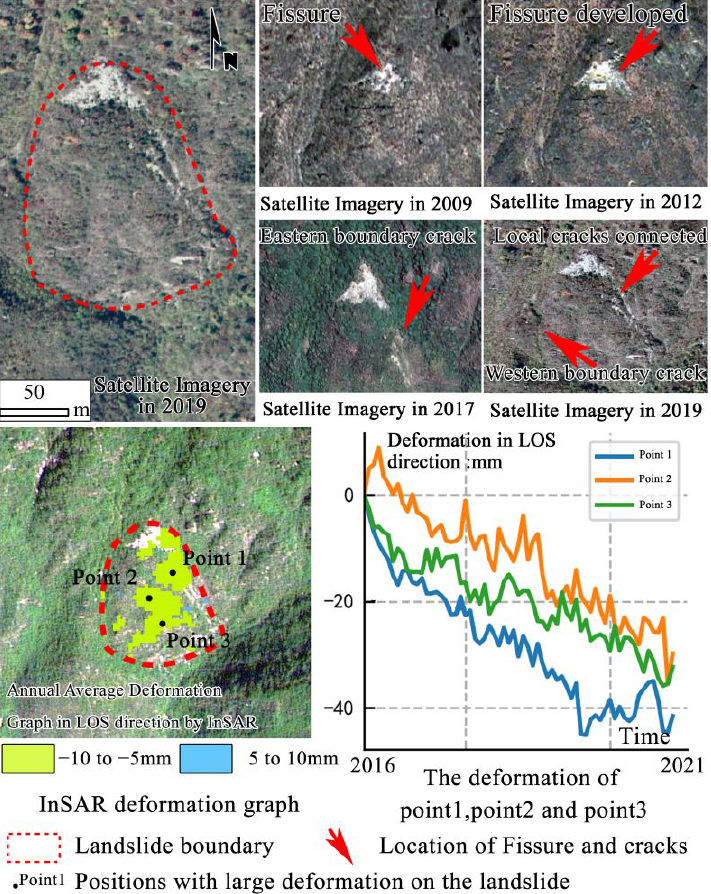
Figure 5. Optical images of landslide S02 acquired in 2009, 2012, 2017 and 2019 (the upper five panels). Deformation velocity of landslide S02 got by InSAR (left lower panel). The deformation in LOS direction of the three points during 2016–2021 are shown in the right lower panel.